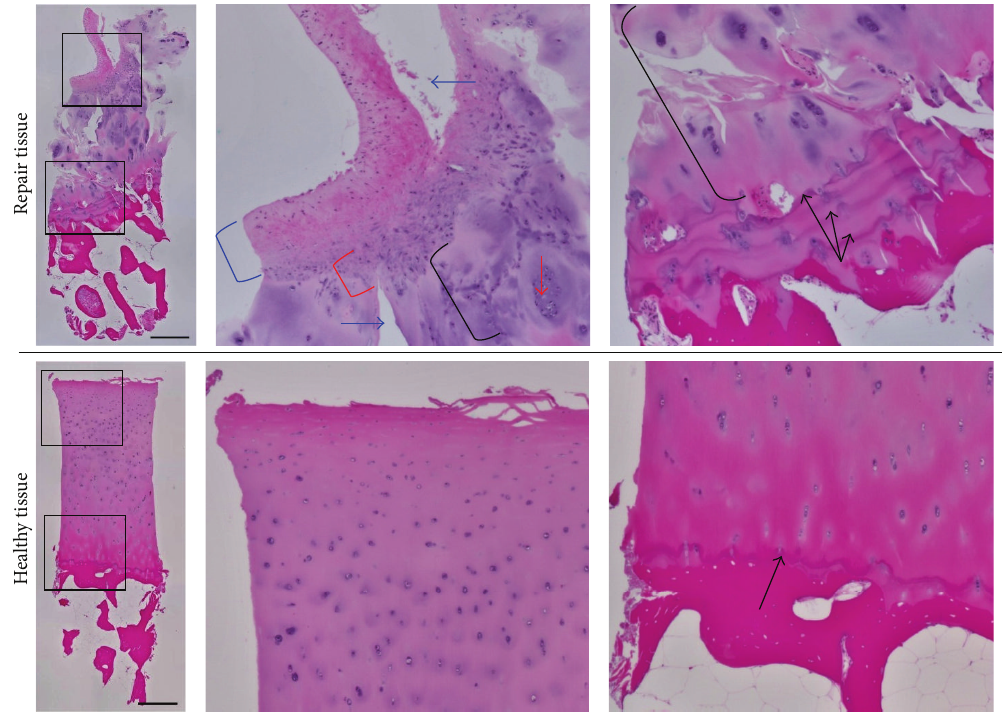
Figure 6: Hematoxylin and eosin stain. Hematoxylin and eosin stain of patient repair tissue and healthy tissue with higher magnification of the superficial and deep zones of the articular cartilage. The superficial zone of the repair tissue contains a layer of fibrocartilage (blue bracket) that transitions to hyaline-like cartilage (red bracket) and then hyaline cartilage (black bracket), with some degenerative changes including chondrocyte clustering (red arrow) and fissuring (blue arrows). The deep zone contains hyaline cartilage (black bracket) with a replicated tidemark (black arrows). The healthy tissue is entirely hyaline cartilage with an established tidemark (black arrow) between the cartilage and the bone. Scale bars = 500 𝜇